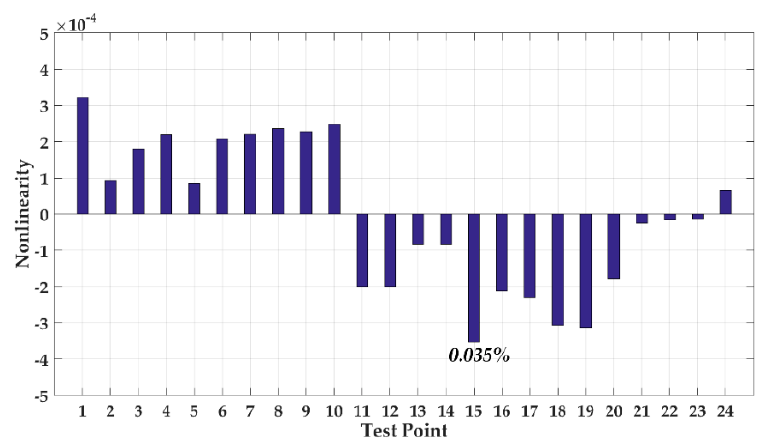
Figure 14. Nonlinearity test result of DRG.